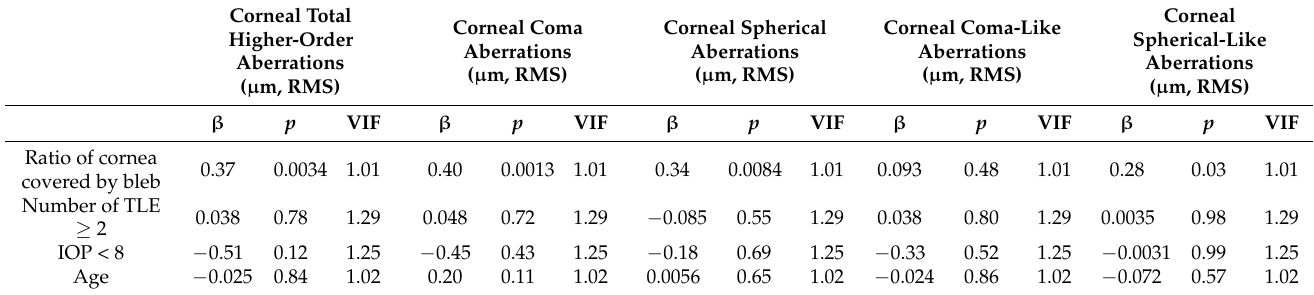
Table 5. Multivariate regression analysis of corneal higher-order aberrations with associated factors in overhanging bleb